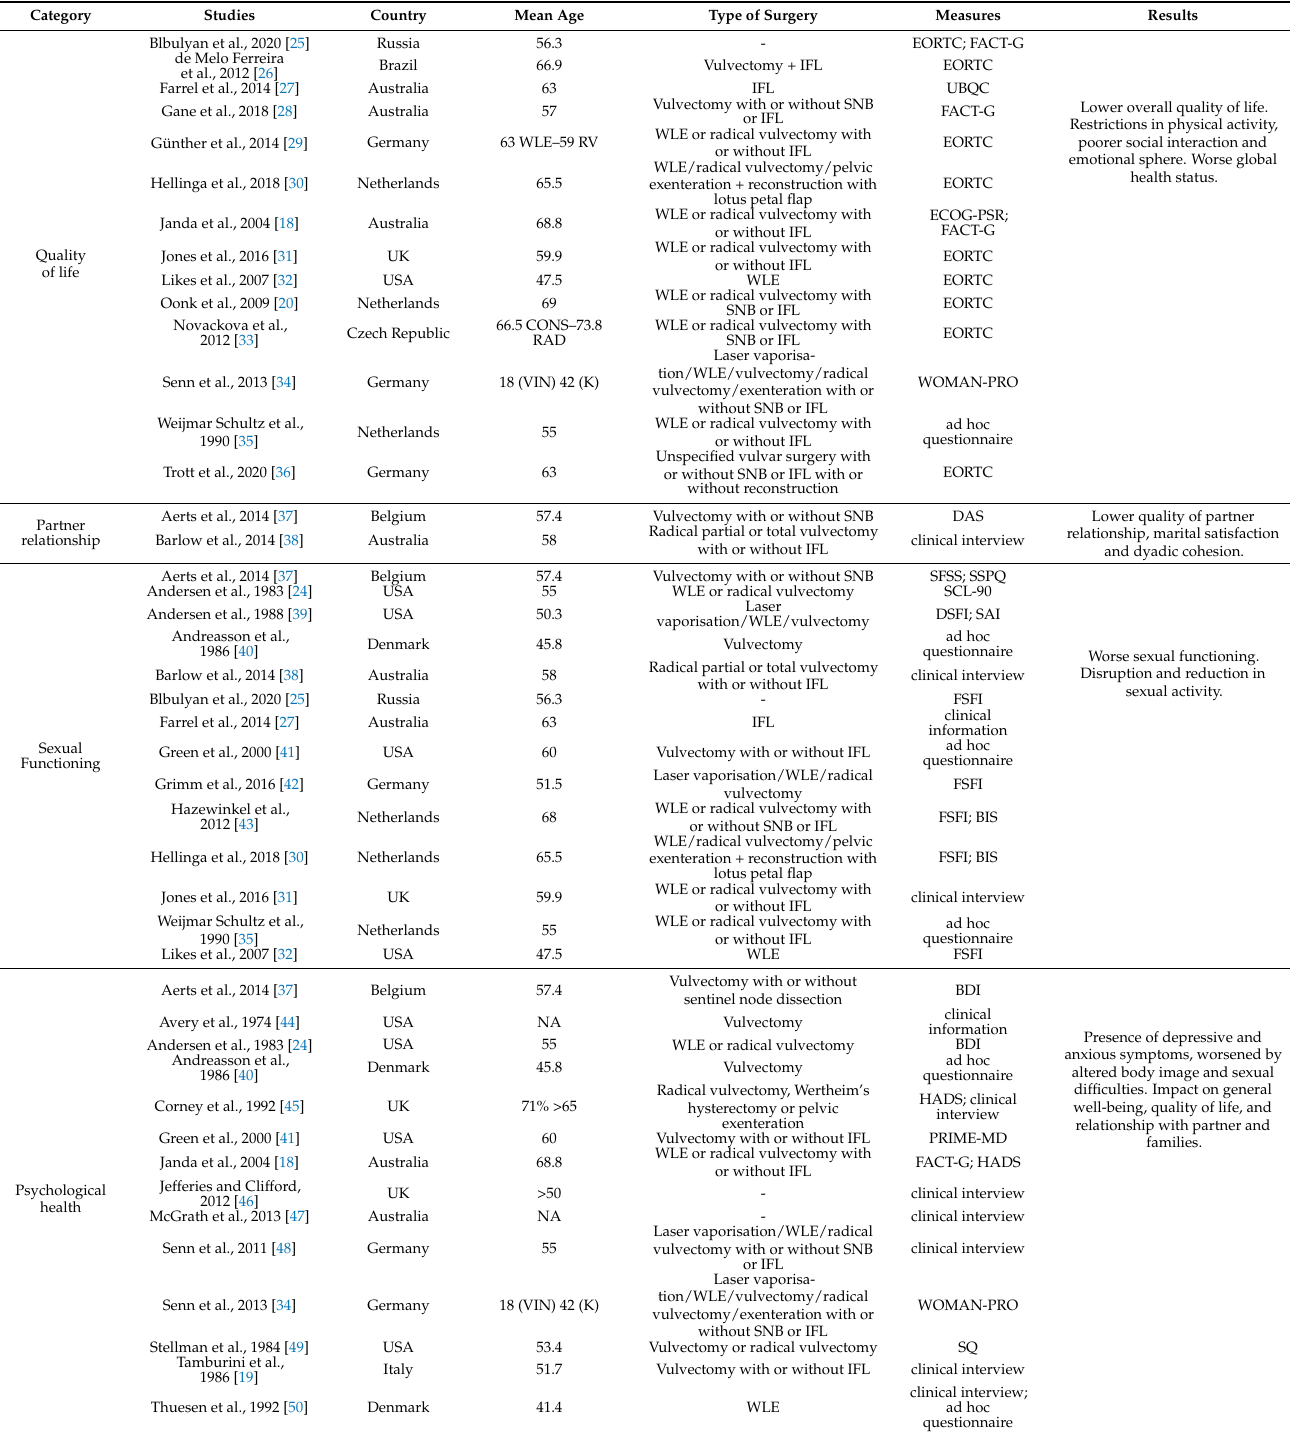
Table 1. Overview of the included